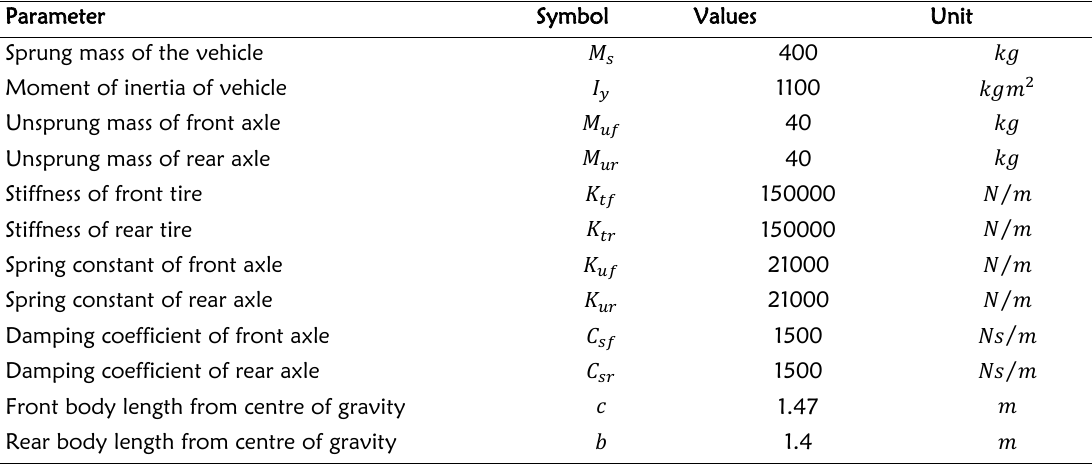
Table 2. Simulation parameters for half car